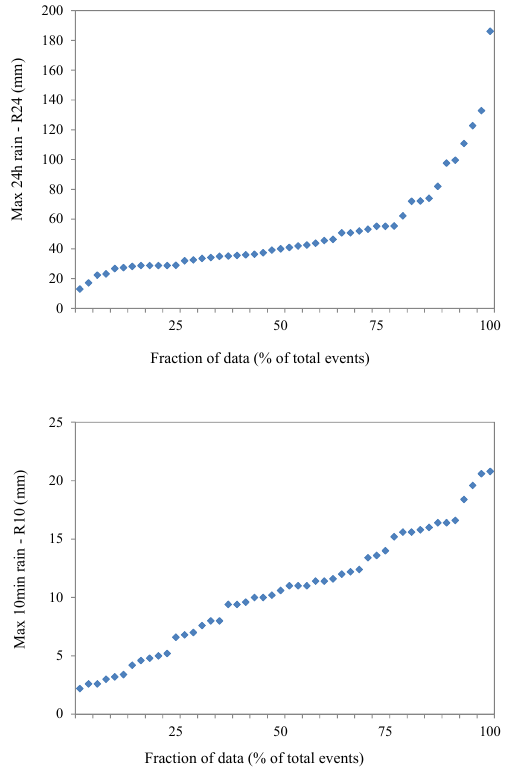
Figure 4. Quantile distribution plots for (a) the maximum 24h ac- cumulated rain (R24) and (b) the maximum 10min accumulated rain (R10) observations (in mm).